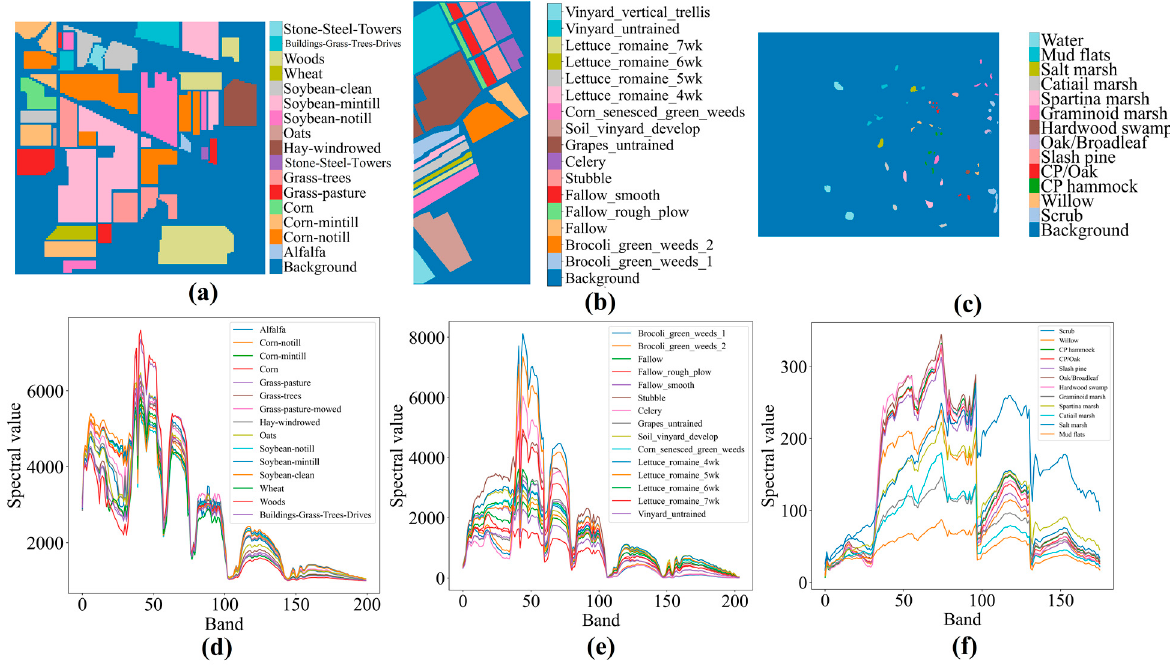
Figure 4. Images of the three HSIs. ( a – c ) are the the ground truth of Indian Pines, Salinas, and KSC. ( d – f ) are the spectral reflectance curves of Indian Pines, Salinas, and KSC.